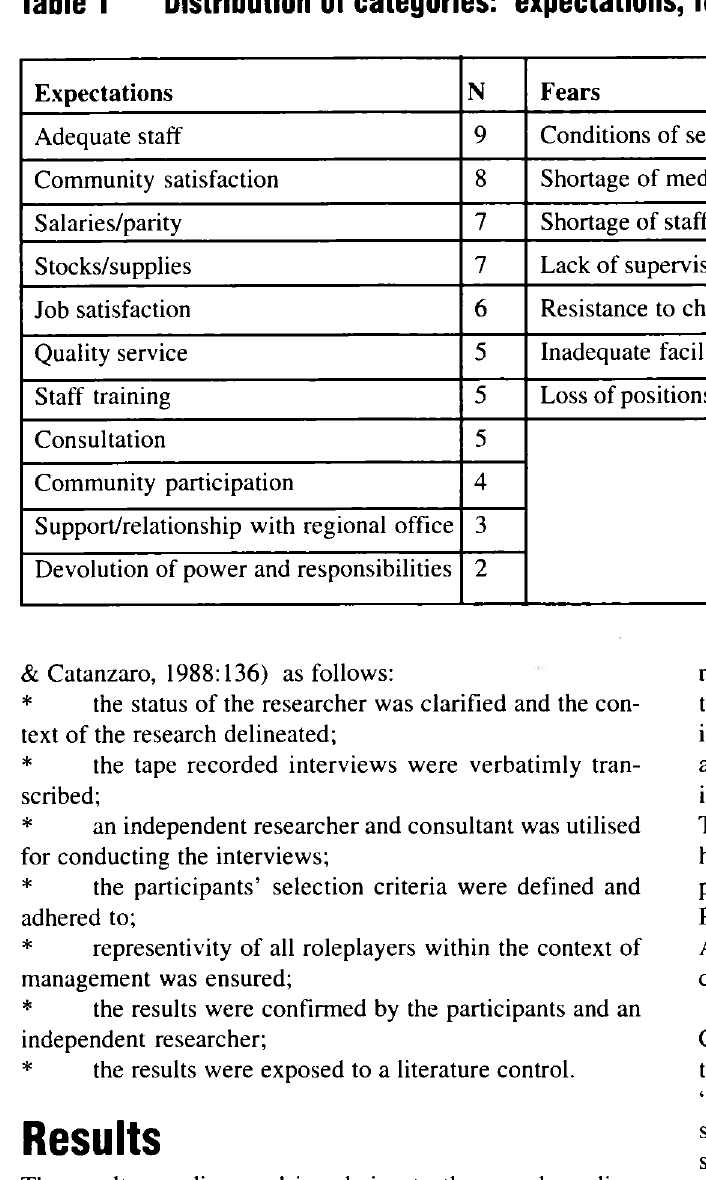
Table 1 Distribution of categories: expectations, fears and